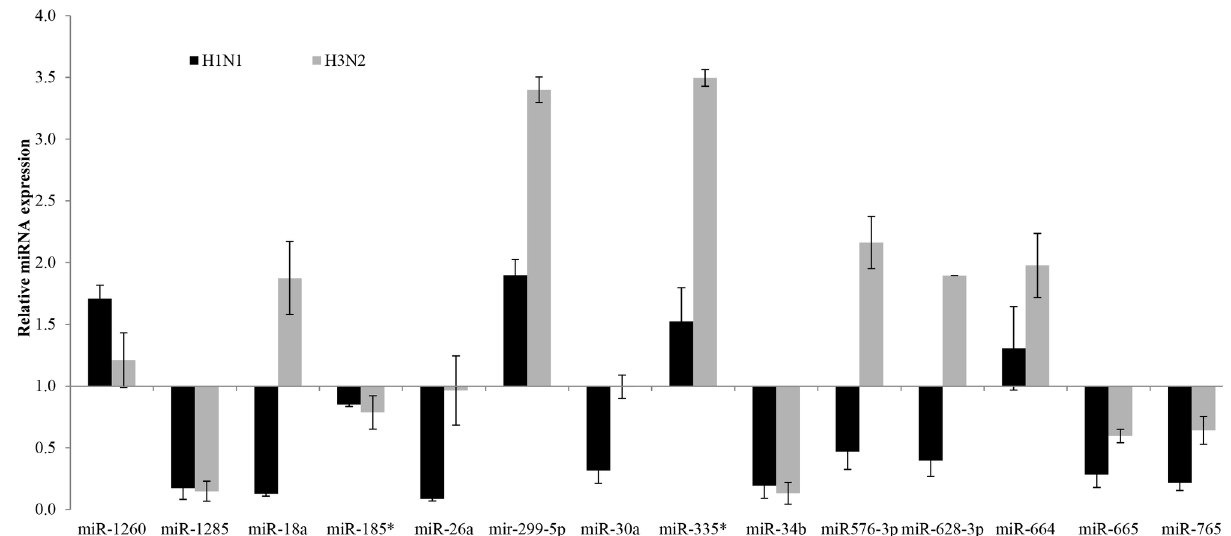
Figure 3. Relative miRNA expression in H1N1 and H3N2 patients. The expression of all 14 miRNAs in blood profiles of H1N1 and H3N2 patients were validated using stem-loop PCR. Relative expression values were normalised to those of healthy controls. Data shown are the mean ± SD, n≥8 for each